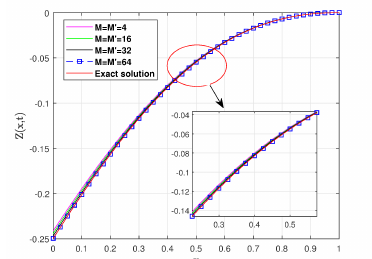
Figure 7. The graph of the AE functions of applying the proposed method with m = m ′ = 1 , η = η 1 = 1 different values of M = M ′ for Example 2.